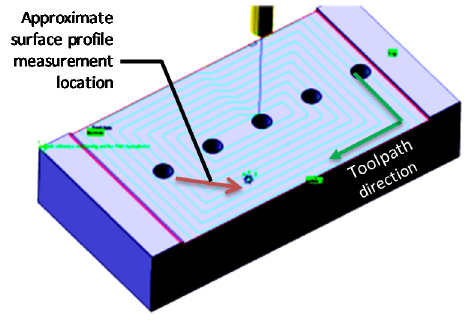
Figure 33. Backlash test token showing toolpath and position of surface profile measurement.